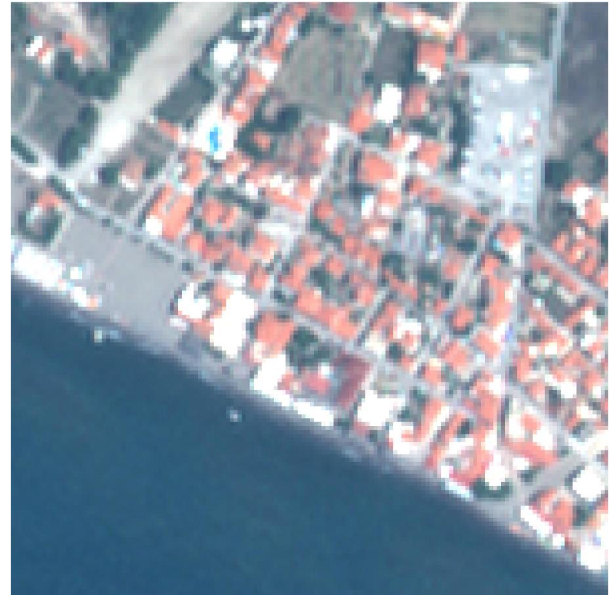
Figure 1. RGB true color composition of a semi-urban area in Lesbos Island (Greece). Taken by Pléiades HR-1B instrumentations, which has a resolution of 0.5 m in the panchromatic and 2 m in the multispectral filters. The picture shows that the area taken by the instrument is at low resolutions, and details cannot be appreciated.